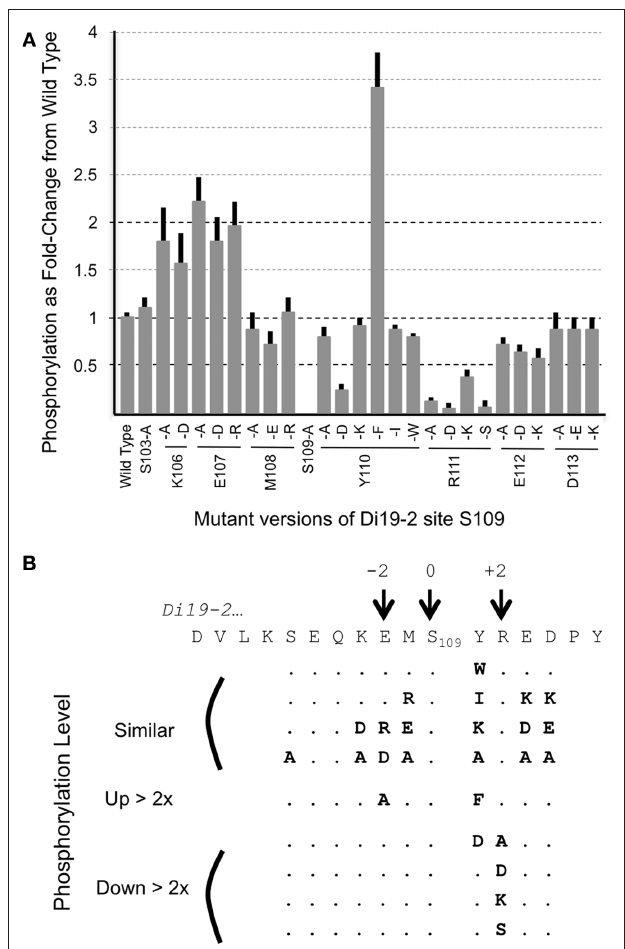
Figure 4 | Kinase reactions with CPK16 comparing relative phospho- labeling of Di19-2-site-S109 and variants. (A) For each amino acid substitution, the fold change in phosphorylation is shown in comparison to phosphorylation levels for the wild type version of the S109 site encoded in G-GFP-S109-ST . All substitutions were engineered by site-specific mutagenesis of the same parental clone, G-GFP-S 109 -ST. All reactions, SDS-PAGE gels, and autoradiograms were performed as described in Figure 2 and in Section “Materials and Methods.” The percentage incorporation of 32 P was determined by analysis of autoradiograms and was normalized to the amount of Coomassie Brilliant Blue-stained protein for each substrate. Results shown are the average of at least four independent analyses for each variant. Error bars show SD. (B) A summary of changes in phosphorylation as a result of substitutions. Peptides with similar phosphorylation potentials are shown first (i.e., changes less than twofold compared to wild type), followed by those that were higher or lower by more